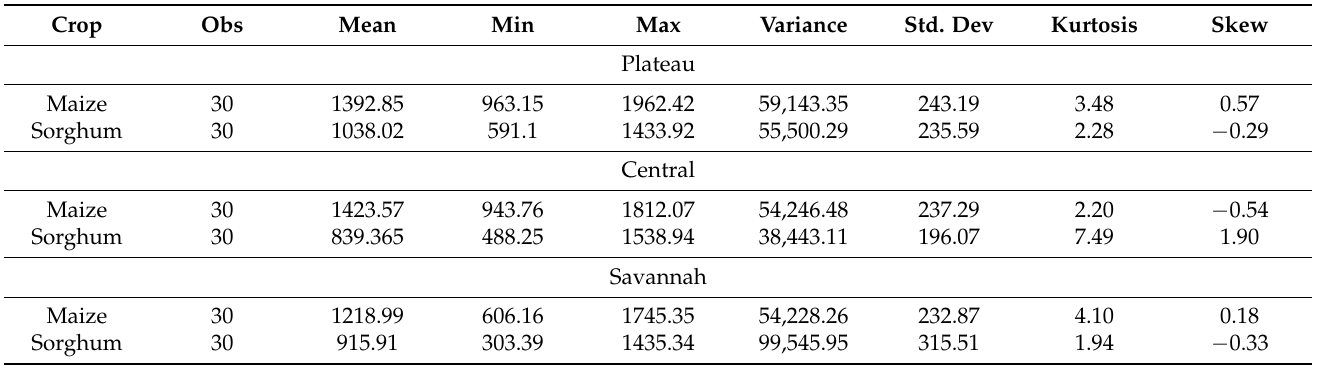
Table 2. Descriptive statistics.